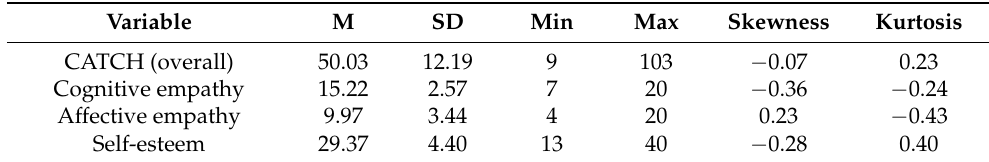
Table 2. Descriptive statistics for the main variables ( N = 405).